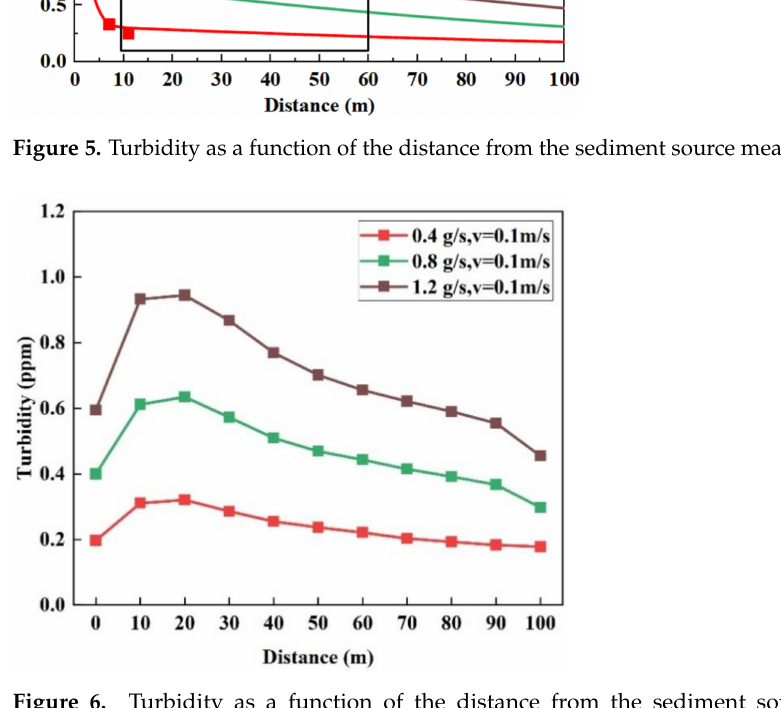
Figure 6. Turbidity as a function of the distance from the sediment source calculated from numerical simulation. Table 3. Parameters adopt for fitting of the experimental data in Figure